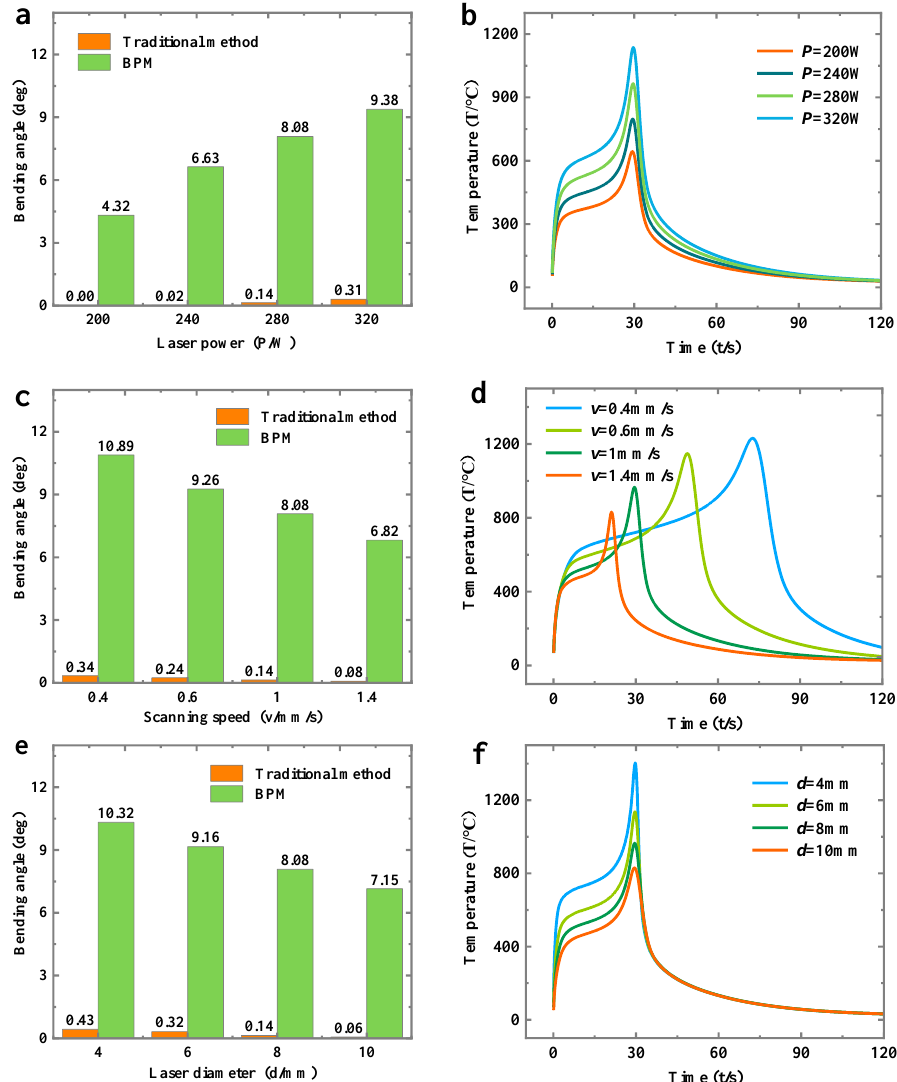
Figure 12. The comparison between the two methods under different processing parameters: ( a ) bending angle (different laser power), ( b ) temperature (different laser power), ( c ) bending angle (different scanning speed), ( d ) temperature (different scanning speed), ( e ) bending angle (different scanning diameter) and ( f ) temperature (different scanning diameter).